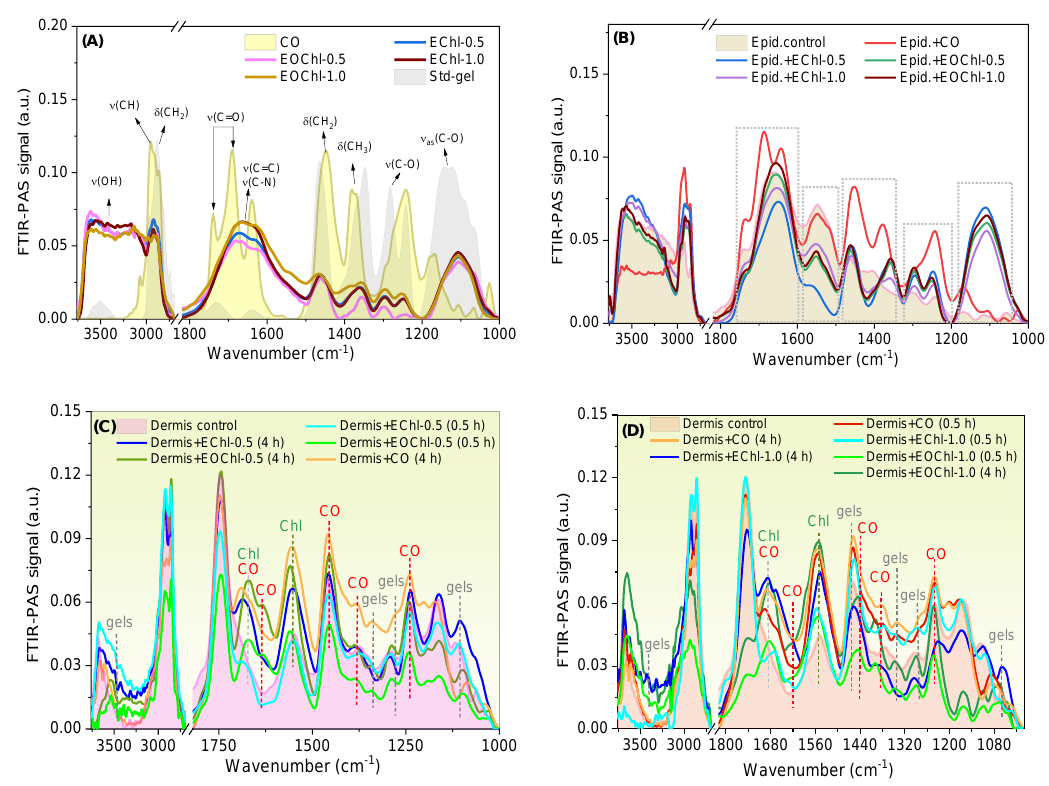
Figure 8. Absorption spectra obtained by FTIR-PAS: ( A ) CO and emulgels; ( B ) human epidermis after 0.5 h of emulgel administration; ( C ) human dermis after 0.5 h and 4 h of administration of the emulgels and CO; ( D ) human dermis after 0.5 h and 4 h administration of EChl-1.0, EOChl-1.0, and CO. Note: vibrations —ν: stretching and δ: angular deformation .